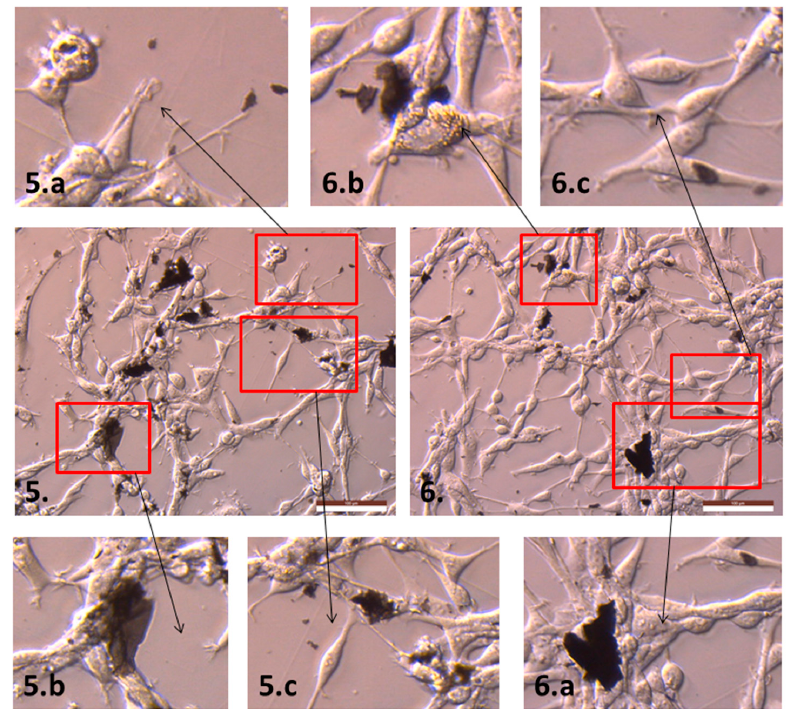
Figure A3. Morphology of U87 cells treated with rGO flakes, as evaluated by optical microscopy. Cells treated with graphene flakes (at concentration of 50 µ g/mL)—(5–6) rGO/Term. Regions of interest marked with red borders, are shown enlarged, and are indicated by black arrows. Scale bar: 100 µ m.